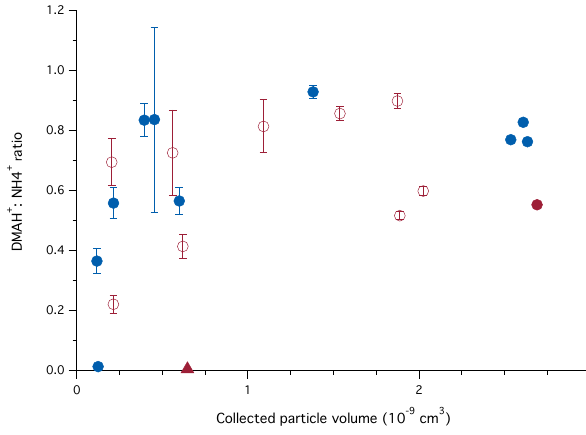
Figure 9. The ratio of summed DMAH + to summed NH + 4 ion signals plotted against the collected particle volume for DMA + H 2 SO 4 particle formation experiments (circles) and for the H 2 SO 4 only (no added DMA) nucleation experiment (triangle). Collections of less than 0.1 × 10 − 9 cm − 3 of sample were excluded due to low signal-to-noise ratio. The filled symbols are periods with nominally 10ppt DMA in the chamber and the open symbols are with 40ppt DMA. Blue symbols indicate periods with 1%H 2 added to the TDCIMS inlet to scavenge radicals, and red symbols are periods without H 2 . The vertical error bars indicate the stan- ) , dimethy- Figure 8. (a) Particulate ion signals for sulfate (SO − 5 dard error of the ion signals. Higher ammonium fractions were more lamine, n -methyl formamide, and ammonia during a nucleation ex- likely for low collected masses (resulting from low chamber aerosol periment with 10ppt DMA and 2.6 × 10 7 cm − 3 H 2 SO 4 (run 1047). mass), possibly because less contaminant ammonia was required to For most of this run, 1%H 2 was added to the TDCIMS inlet as alter the composition of the particles (see Sect. 4). DMAH + was a gas-phase radical scavenger, except for the period between the never observed to be more abundant than NH + in the particles dur- 4 dashed vertical lines. During this period, the n -methyl formamide ing any of increased about 30-fold, while the other species underwent more modest changes. (b) Size-resolved particle mass collected during this period. White gaps indicate background periods when no par- ticles were collected. Open circles show the volume mean diameter for collected particles.